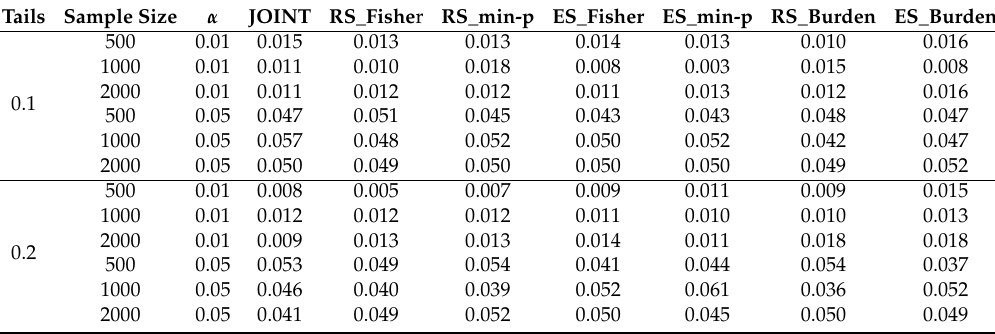
Table 1. The estimated type I error rates for all